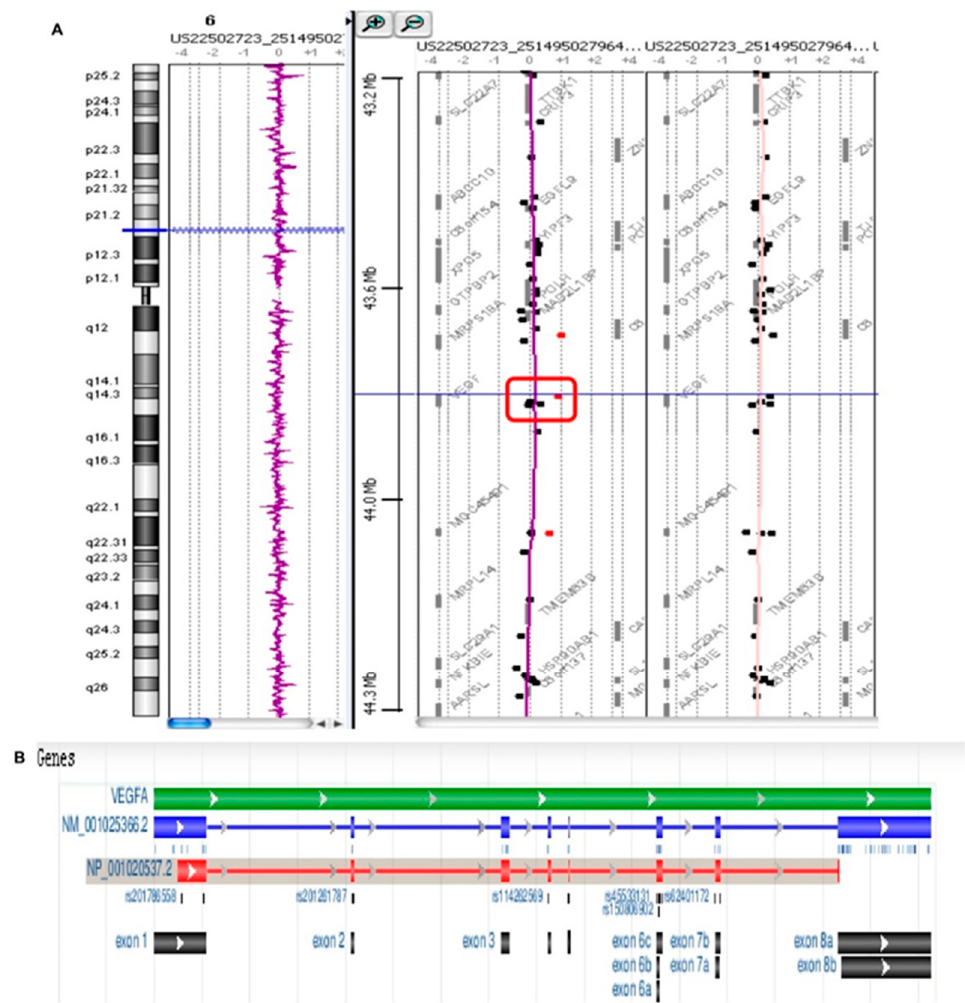
Figure 12. Array CGH analysis. ( A ) Patients affected by peri-implantitis show a heterozygote duplication in a genome portion corresponding to a region of chromosome 6, starting at the 43846044 bp position and stopping at 43862079 bp for a total of approximately 16 kb (red square). ( B ) This duplication was not detected in the control group (patients not affected by peri-implantitis)